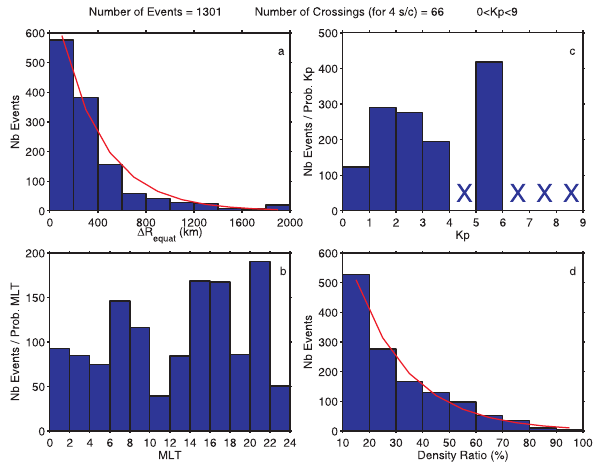
Fig. 2. Statistical results on the density irregularities observed dur- ing all 264 plasmasphere crossings: (a) the number of events as a function of the transverse equatorial size 1 R equat (in km), (b) the MLT distribution divided by the probability to have a MLT in each range, (c) the K p distribution divided by the probability to have a K p in each range (a cross means no data), and (d) the density ratio. The red curves are exponential least-squares fitting curves.